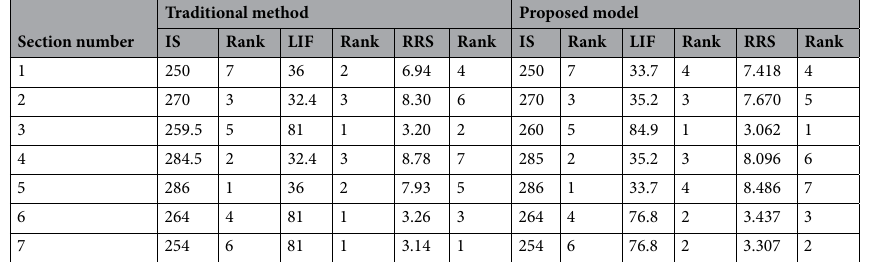
Table 7. Output RRS results of traditional method and proposed model.